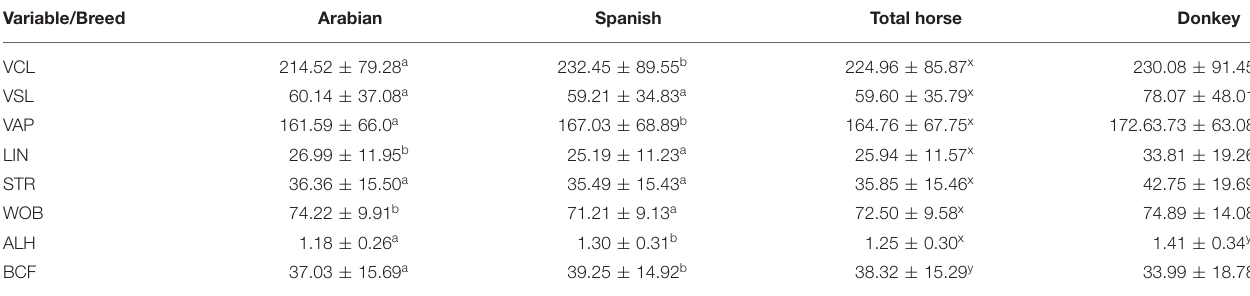
TABLE 1 | Sperm kinematic variables (mean ± SEM) in horses and donkey. Variable/Breed